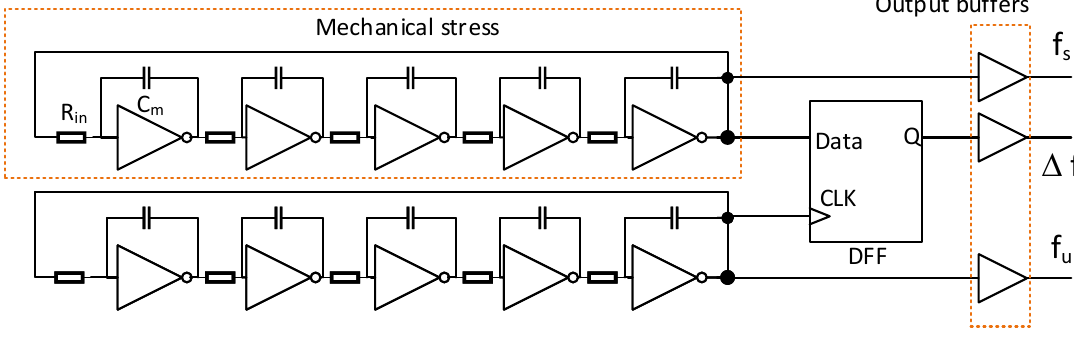
Figure 6. Block diagram of the sensor